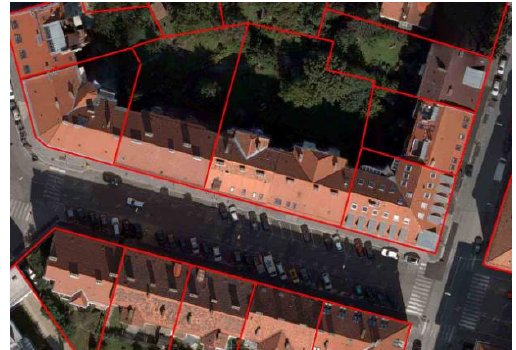
Figure 1. Overlaying the cadastral map (depicted in red) over the true orthophoto shows displacements of the cadastral boundaries versus the